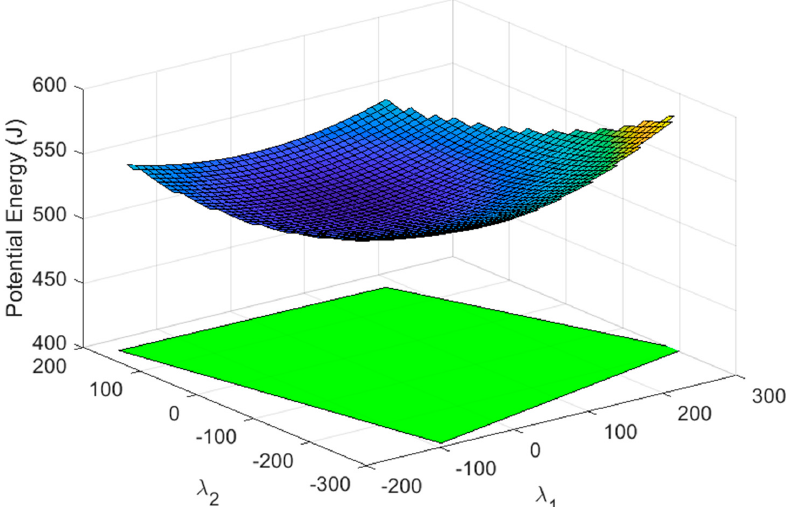
Figure 11. Surface section that represents the potential energy of all the cables when the two grippers are attached in cables 1 and 8. The green polygon defines the region of the nullspace that provides feasible tension values in all cables. It is different form the red polygon from Figure 7 because in this case the weight of the two grippers is being considered.